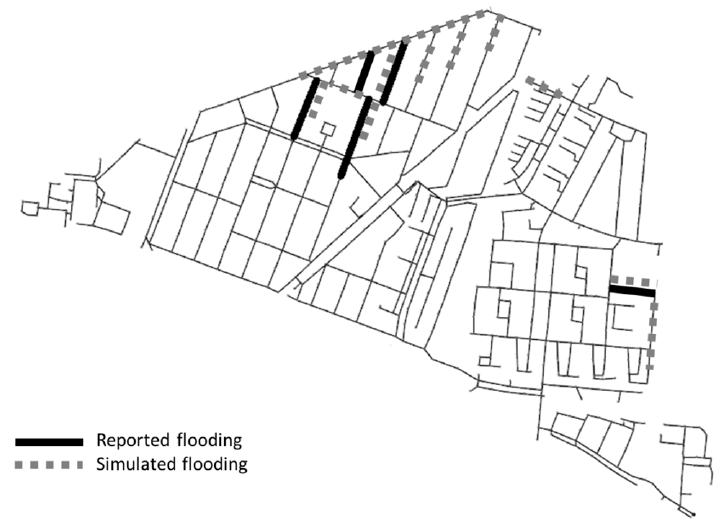
Figure 3. Comparison of reported and simulated flood areas in the ‘Tuindorp’ catchment during the rainfall event on 4 November 2013 in order to validate the InfoWorks model.